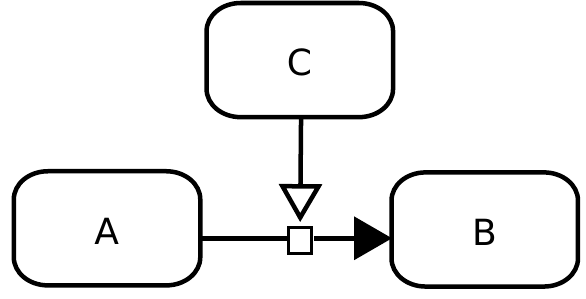
Figure 2.43: The reaction to represent in Entity